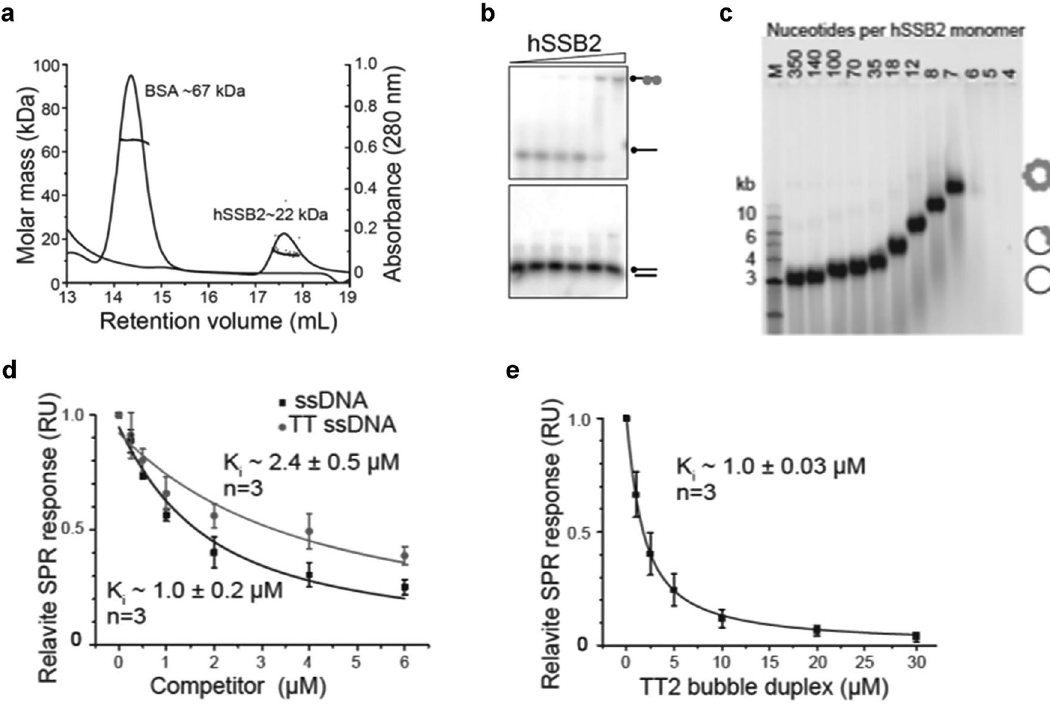
Figure 4. Analysis of hSSB2 binding footprint and interaction with CPDs. ( a ) hSSB2 forms monomers in a reducing solution (mimicking the normal reduced state of the nucleus). SEC-MALS spectrum of hSSB2-OB protein (~ 250 μg) that was applied to a Superose 12 column with an in line MALLS detector to determine weight-averaged molecular weight in solution. The elution profile (continuous line) and light-scattering (filled black square) are shown. Void volume (7.89 mL). hSSB2 is ~ 22 kDa; BSA (67 kDa) is shown as a comparison. ( b ) Electrophoretic mobility shift analysis showing binding of recombinant hSSB2 to ssDNA substrates, ssDNA (top) and dsDNA (bottom). The radiolabel on the ssDNA is marked with a black circle. hSSB2 binding to the oligonucleotide is indicated by grey circles. ( c ) Agarose gel shift analysis of hSSB2-OB (0–30 µM) binding to single-stranded circular bacteriophage DNA ϕX174. Nucleotides of DNA bound per hSSB2-OB monomer present are indicated. hSSB2-OB saturates bacteriophage ssDNA binding with a 5–6 nucleotide footprint (once bacteriophage ssDNA is saturated with hSSB2, this inhibits ethidium bromide intercalation and thus DNA staining), indicating a high-density binding mode. ( d ) hSSB2-OB binds the T-T lesion with almost the same affinity as it does normal ssDNA. SPR competition experiments where hSSB2-OB was injected along with increasing concentrations of a 6 mixed base single-stranded oligonucleotide in the presence (GATTGC) or absence (GAT TGC; wild-type) of a CPD dimer (denoted as TT), respectively, onto a Biacore SA chip immobilized with biotinylated wild-type ssDNA. The decrease in binding of hSSB2-OB to the chip due to the inhibition from the free ssDNA was measured (inhibition constant K i ; indicated) using the steady state equilibrium values from the binding curves. Experiments were done in triplicate (n = 3). ( e ) hSSB2-OB can recognize a 2-base stretch of non-complementary ssDNA. hSSB2-OB is flowed over the immobilised wild-type ssDNA in the presence of increasing amounts of a double-stranded oligonucleotide with a 2 nucleotide ‘bubble’ in the centre. Experiments were done in triplicate (n =